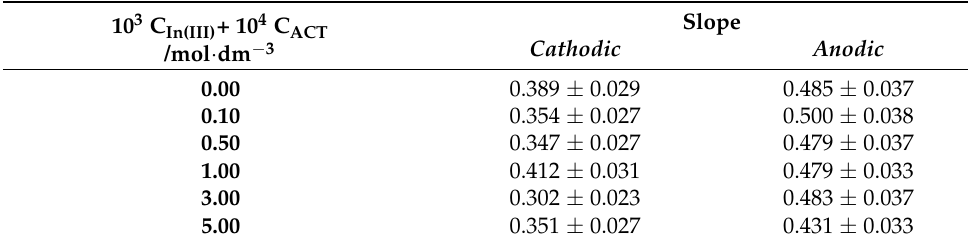
Table 2. The values of the slope of the dependencies of ln(| I p |) vs. ln( v ), where I p — the peak current, v — the scan rate.